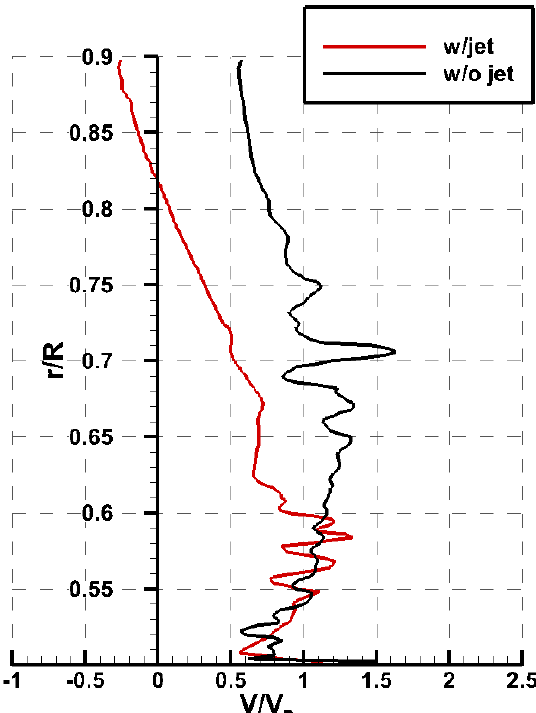
Figure 10. Tangential velocity distribution at the center of the slit ( J A = 0.4).